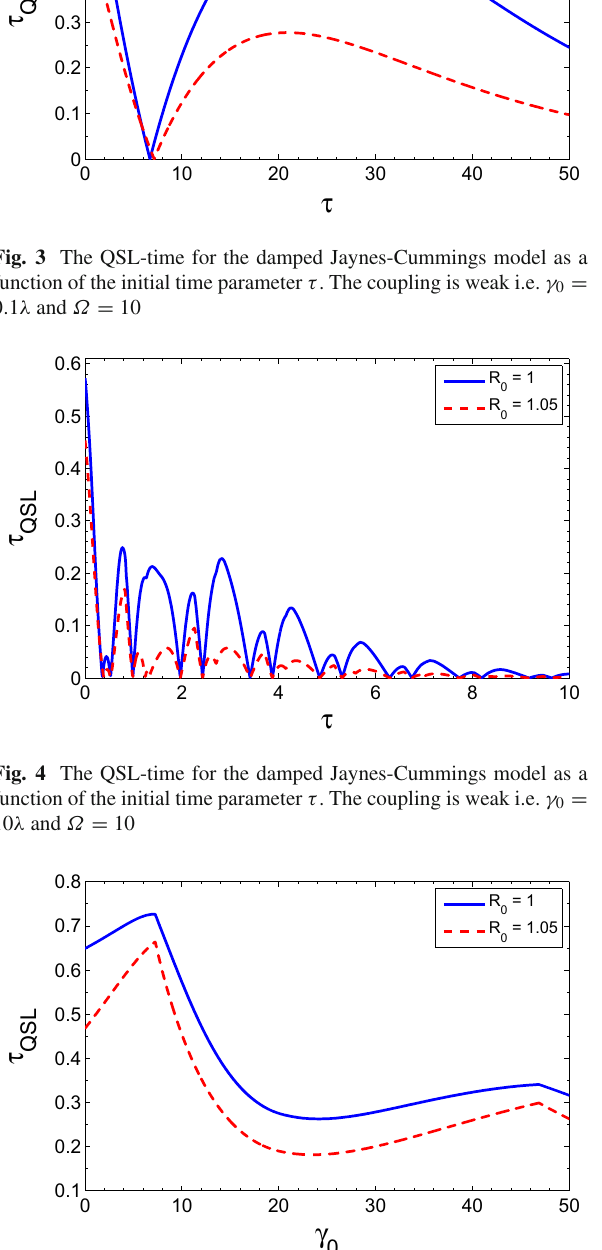
dedreases when the mode frequency Ω increases. Due to the inverse dependence of Ω on Hawking temperature T H